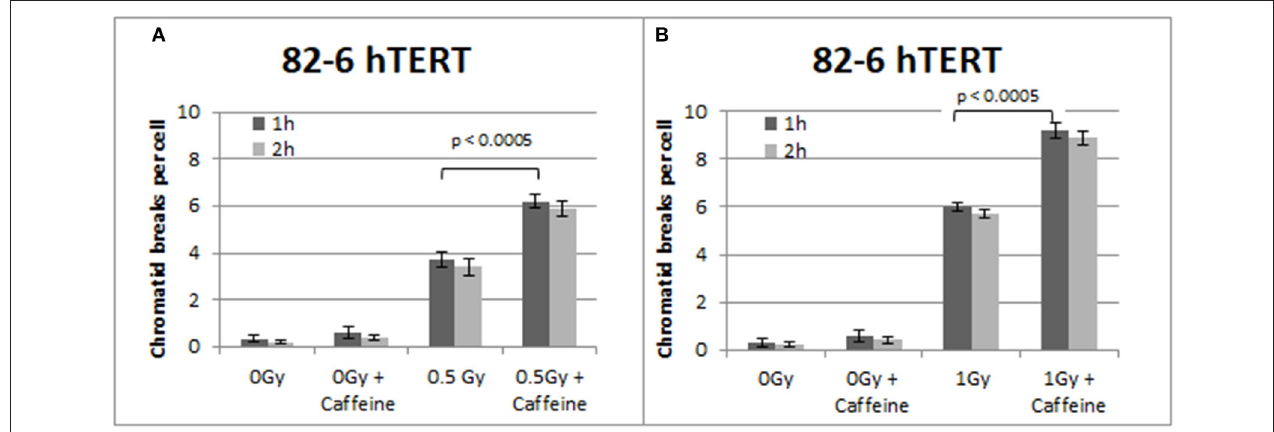
FIGURE 2 | (A) Yield of CBs in 82-6 hTERT cells, treated with Caffeine or left untreated, following exposure to 0.5Gy. (B) As in (A) for cells exposed to 1Gy. The cells were harvested at 1 and 2h after IR. Both graphs also show the yield of chromatid breaks in the unirradiated control groups (Mean ± SD based on three independent experiments; statistically significance criterion: p ≤